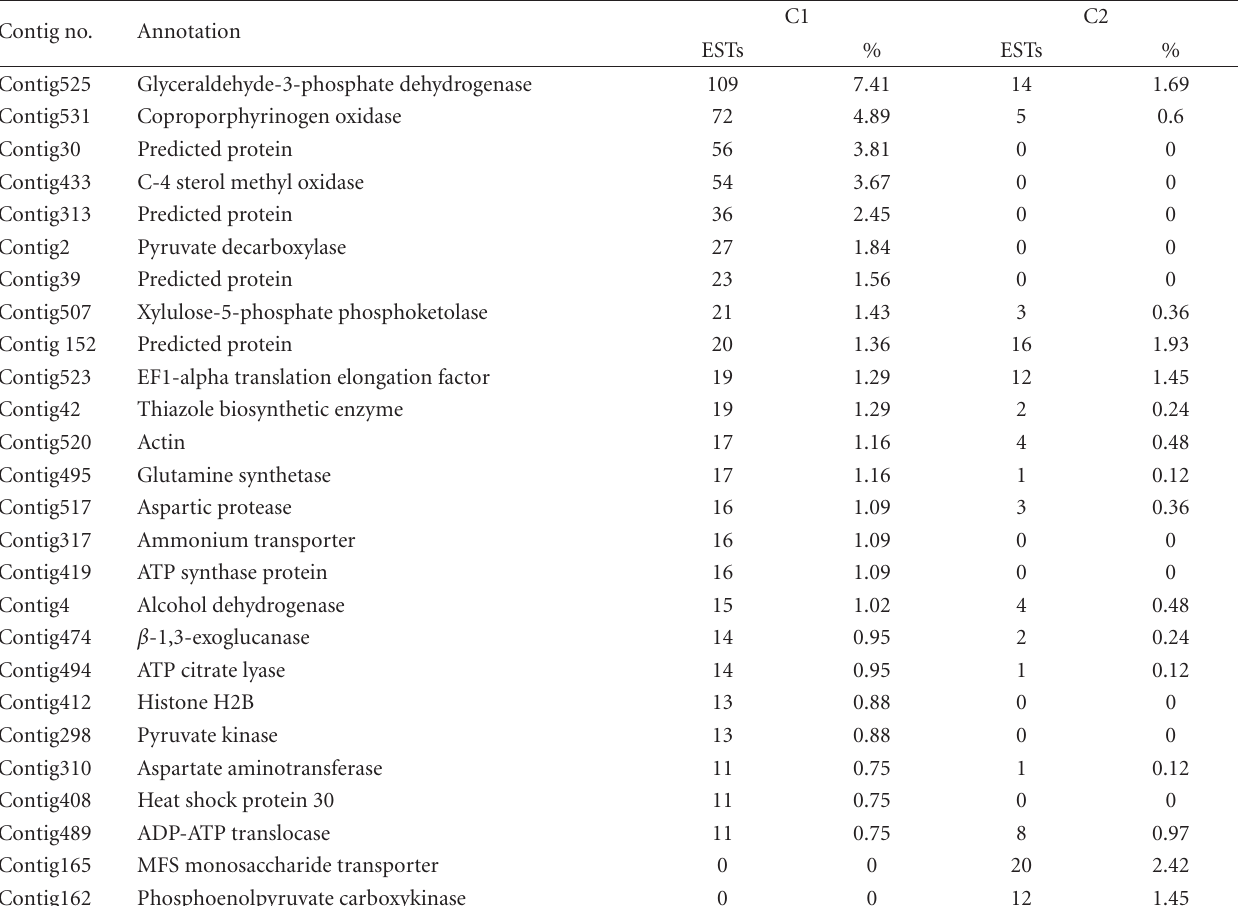
Table 1: The di ff erence of high-redundancy genes expression between cDNA libraries from C. cupreum . Contig